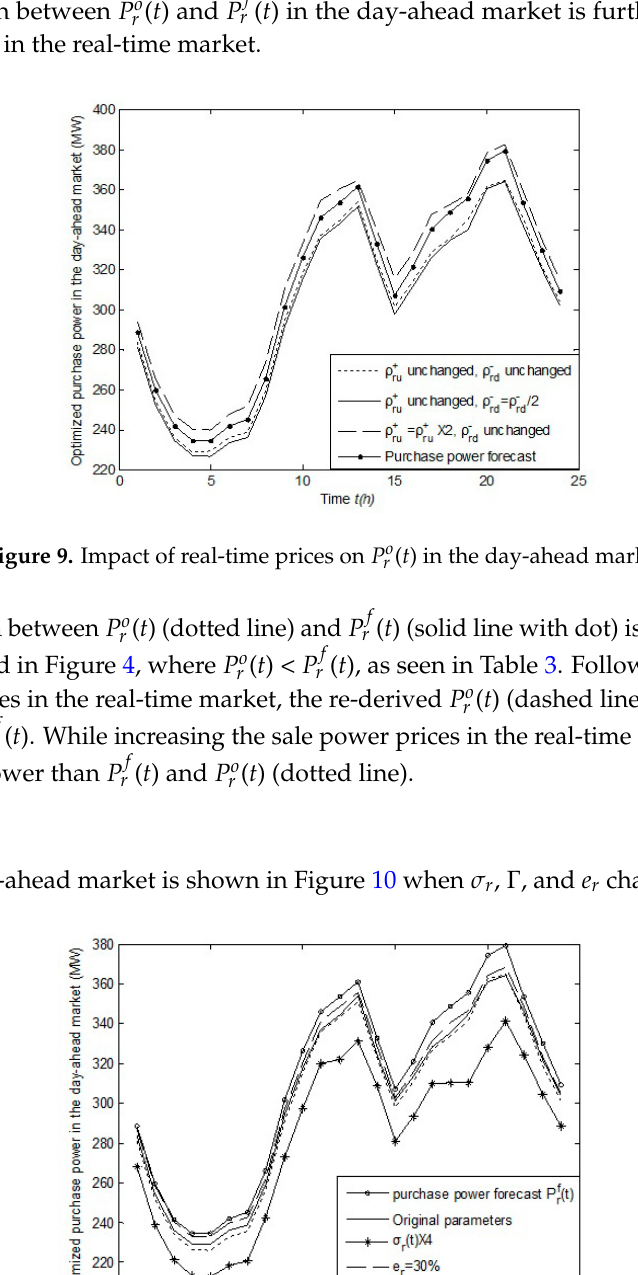
Figure 10. P o ( t ) in the day-ahead market when σ r , Γ , and e r change, respectively. r